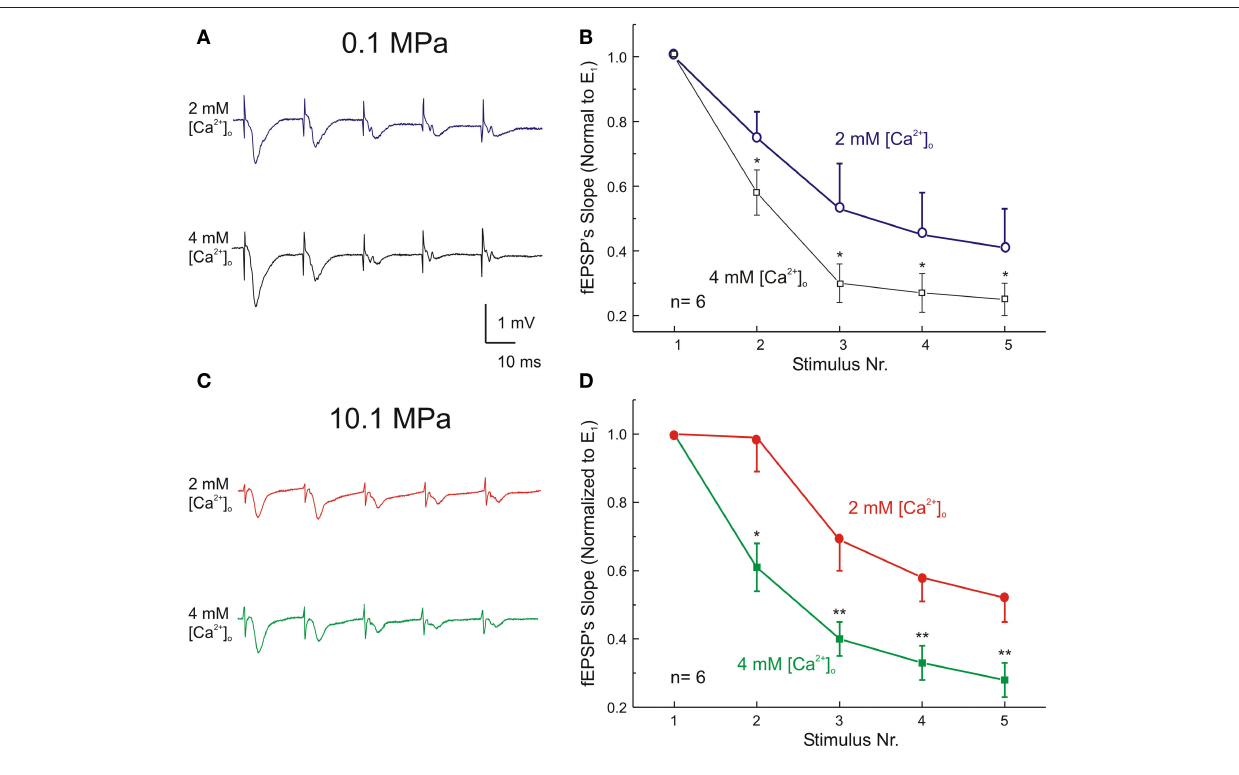
its corresponding condition of [Ca 2 + ] and pressure. Effect of [Ca 2 + ] o at pressure of 0.1 MPa (B) and at 10.1 MPa (D) . * p < 0.05, ** p < 0.01 depict statistical difference between stimuli at 2 mM and 4 mM [Ca 2 + ] (independent t -test). All graphs display means ± SE ( n = 6 for o at each 1